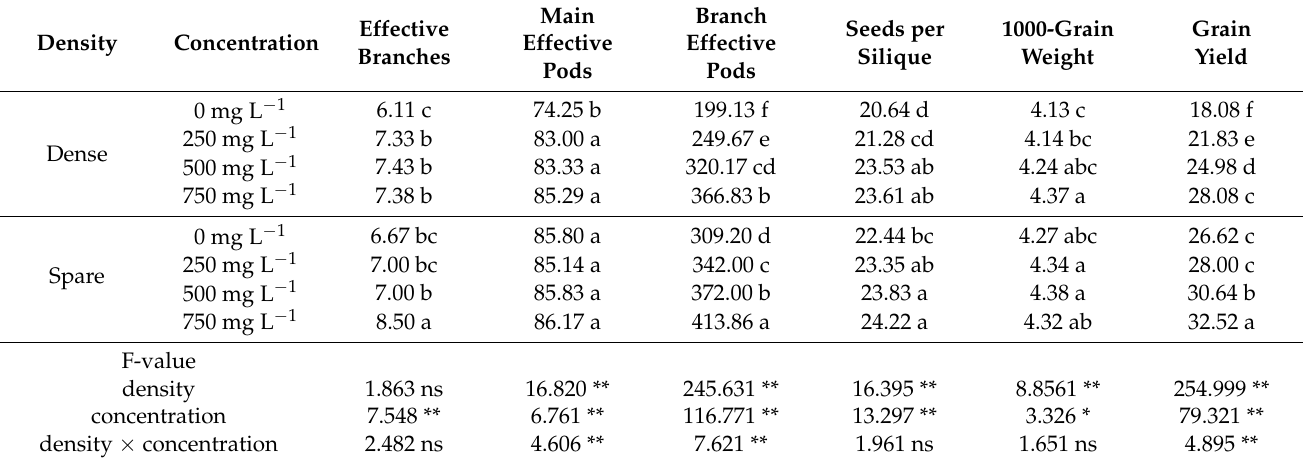
Table 4. Effects of uniconazole on yield and yield components of rapeseed in two sowing densities.